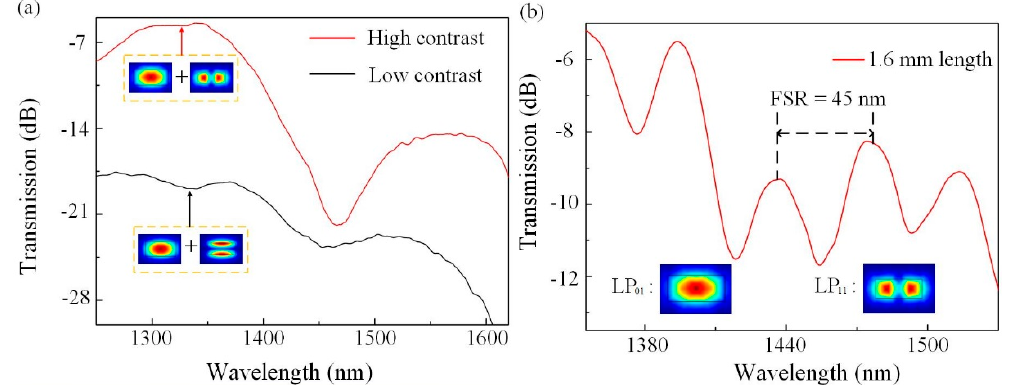
Figure 4. ( a ) The spectral comparison of one POFI with different polarization input. ( b ) Transmission spectrum of one POFI with a polymer fiber length of 1.6 mm and the modes taking part in interference.